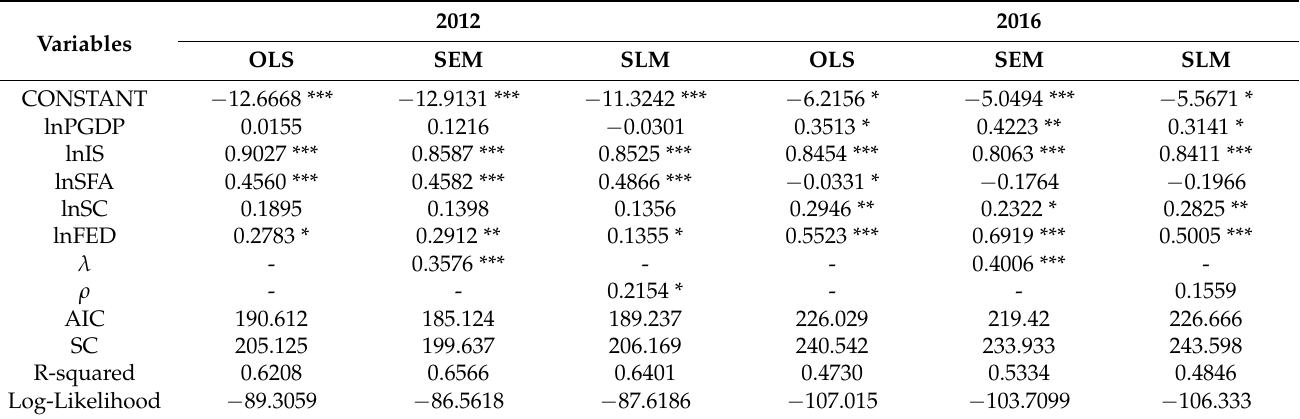
Table 2. Parameter estimation results of econometric models in 2012 and 2016.